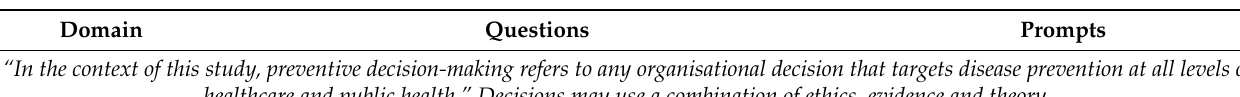
Table 1. Semi-structured interview